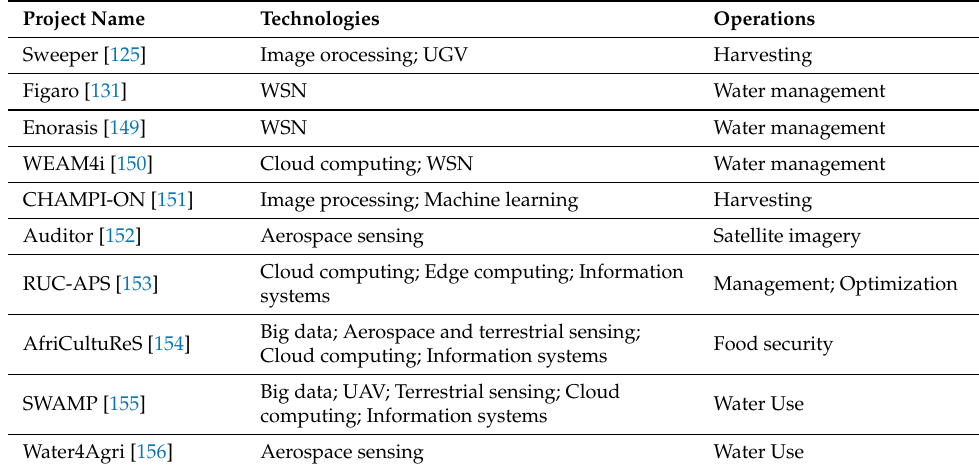
Table 5. Smart Farming projects in EU.